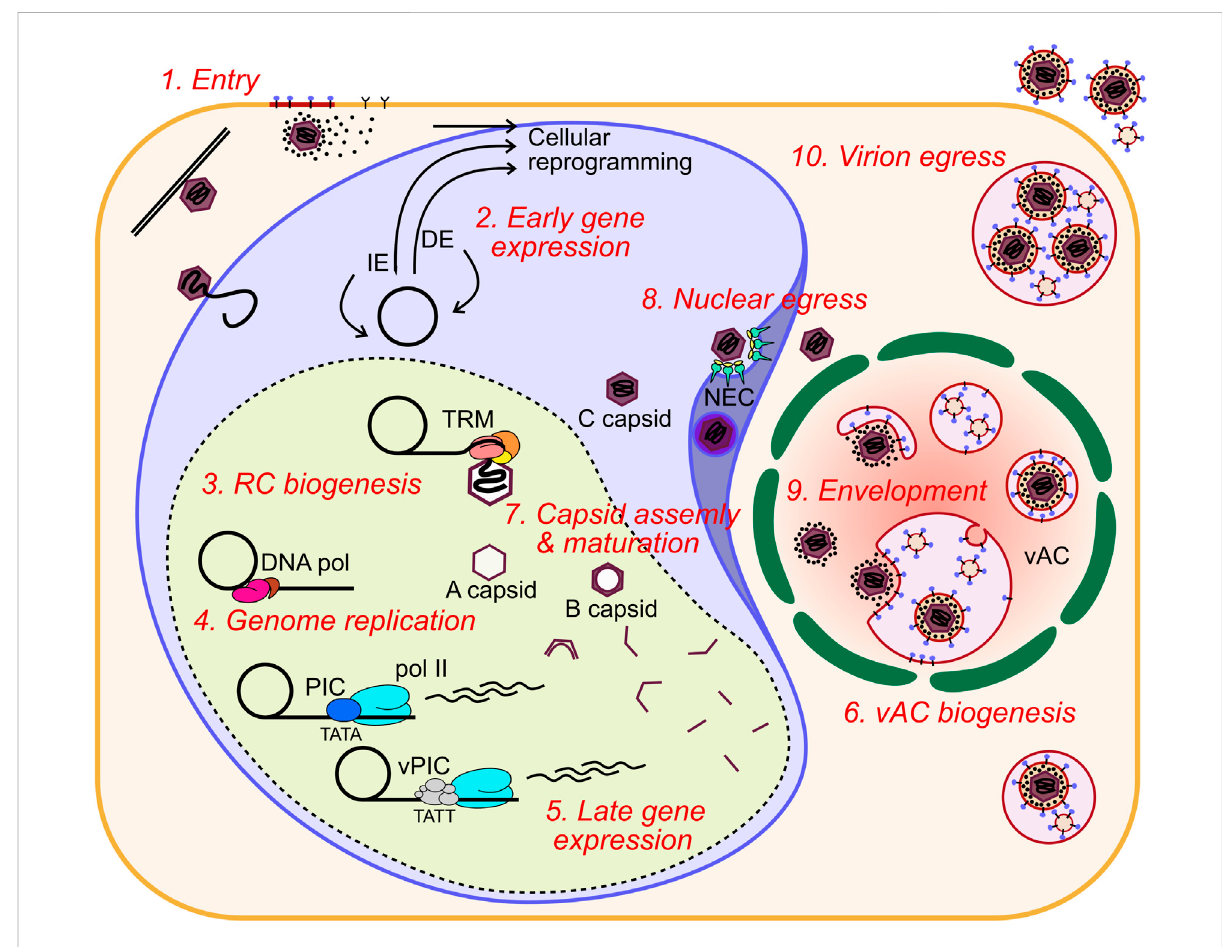
FIGURE 11 HCMV lytic replication proceeds sequentially through 10 checkpoints, with completion of each essential for production of infectious virions. These are 1) entry, 2) early gene expression, 3) RC biogenesis, 4) viral genome replication, 5) late gene expression, 6) vAC biogenesis, 7) capsid assembly and maturation, 8) nuclear egress, 9) envelopment, and 10) cellular egress. IE, immediate early; DE, delayed early; DNA pol, viral DNA polymerase complex; RC, replication compartment;, PIC, pre-initiation complex; vPIC, viral pre-initiation complex; pol II, RNA polymerase II complex; TRM, tripartite terminase complex; NEC, nuclear egress complex; vAC, viral assembly